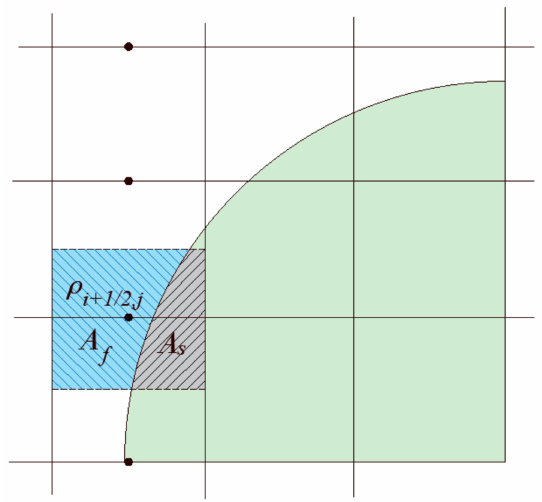
Figure 8. Evaluating the density in the interface